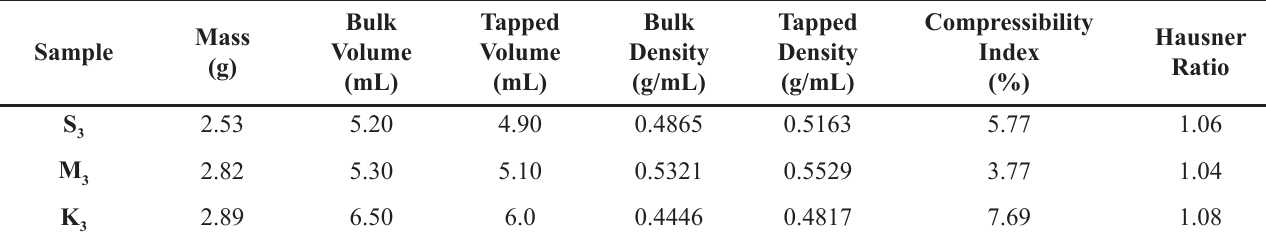
TABLE VII - Micromeritic properties of cefuroxime axetil solid dispersions